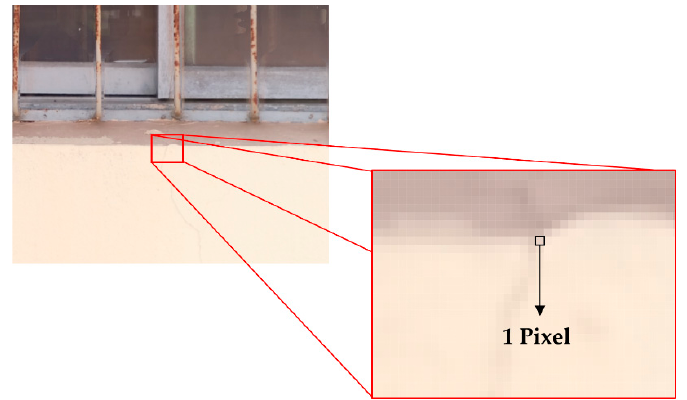
Figure 3. Unit pixel size for the analysis data image.